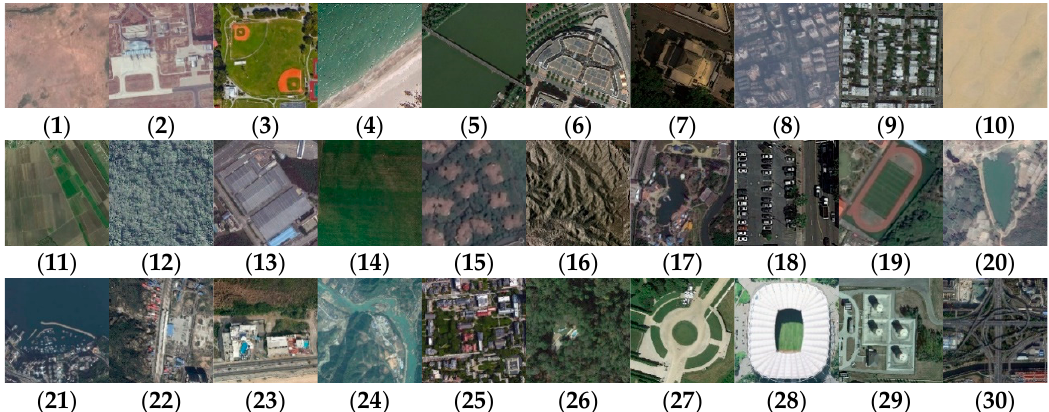
Figure 2. Class representatives of the AID dataset: ( 1 ) airport; ( 2 ) bareland; ( 3 ) baseball field; ( 4 ) beach; ( 5 ) bridge; ( 6 ) center; ( 7 ) church; ( 8 ) commercial; ( 9 ) dense residential; ( 10 ) desert; ( 11 ) farmland; ( 12 ) forest; (13) industrial; ( 14 ) meadow; ( 15 ) medium residential; ( 16 ) mountain; ( 17 ) park; ( 18 ) parking; ( 19 ) playground; ( 20 ) pond; ( 21 ) port; ( 22 ) railway station; ( 23 ) resort; ( 24 ) river; ( 25 ) school; ( 26 ) sparse residential; ( 27 ) square; ( 28 ) stadium; ( 29 ) storage tanks; ( 30 ) viaduct.